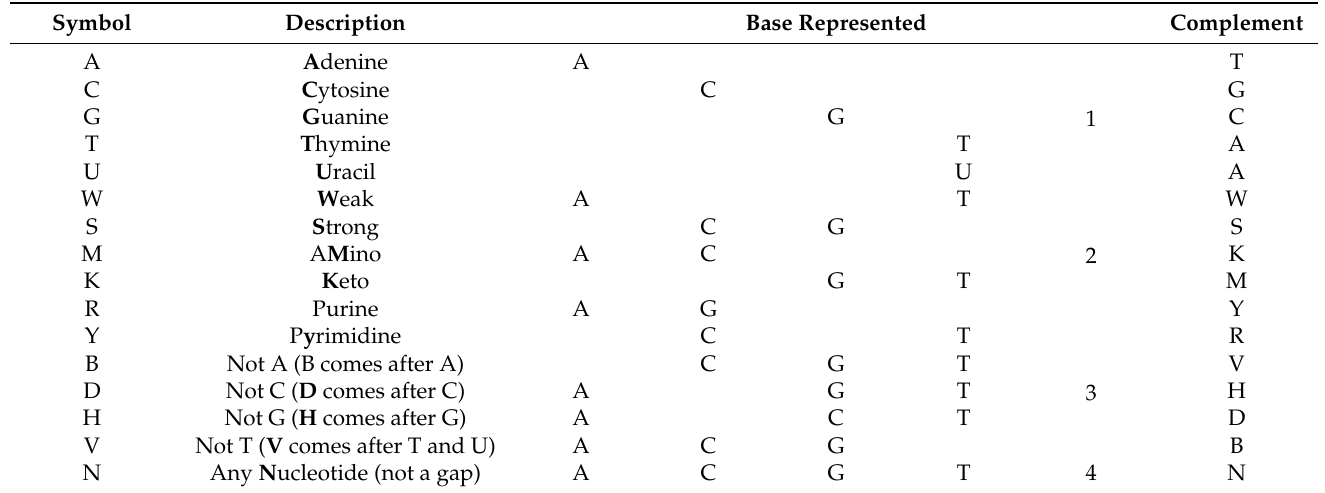
Table 2. Complementary rules